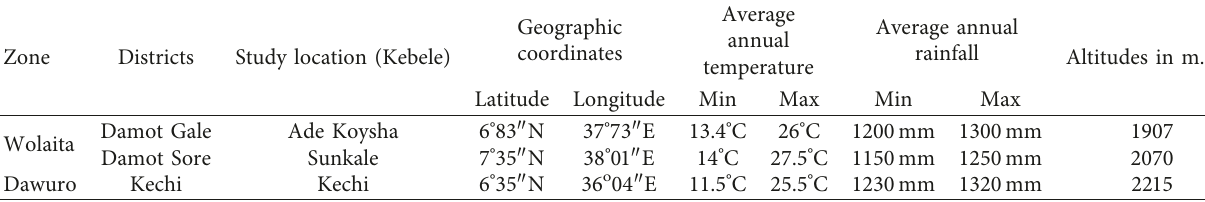
Table 1: Specific descriptions of the study area’s experimental sites.